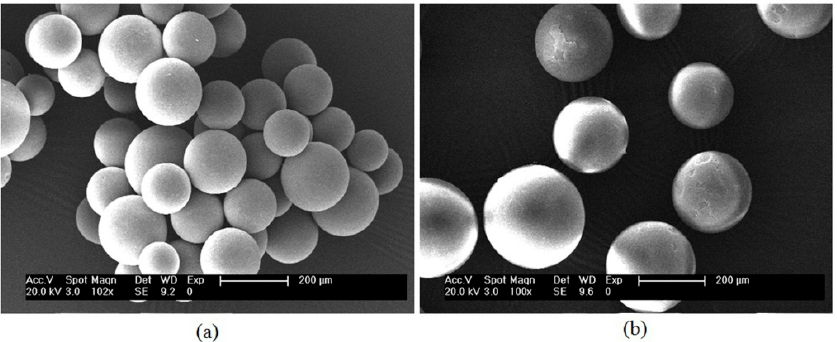
Figure 1. SEM analysis of surface morphologies of Sepabeads EC-EP support ( a ) and immobilized enzyme EC-EP-AFEST ( b ).